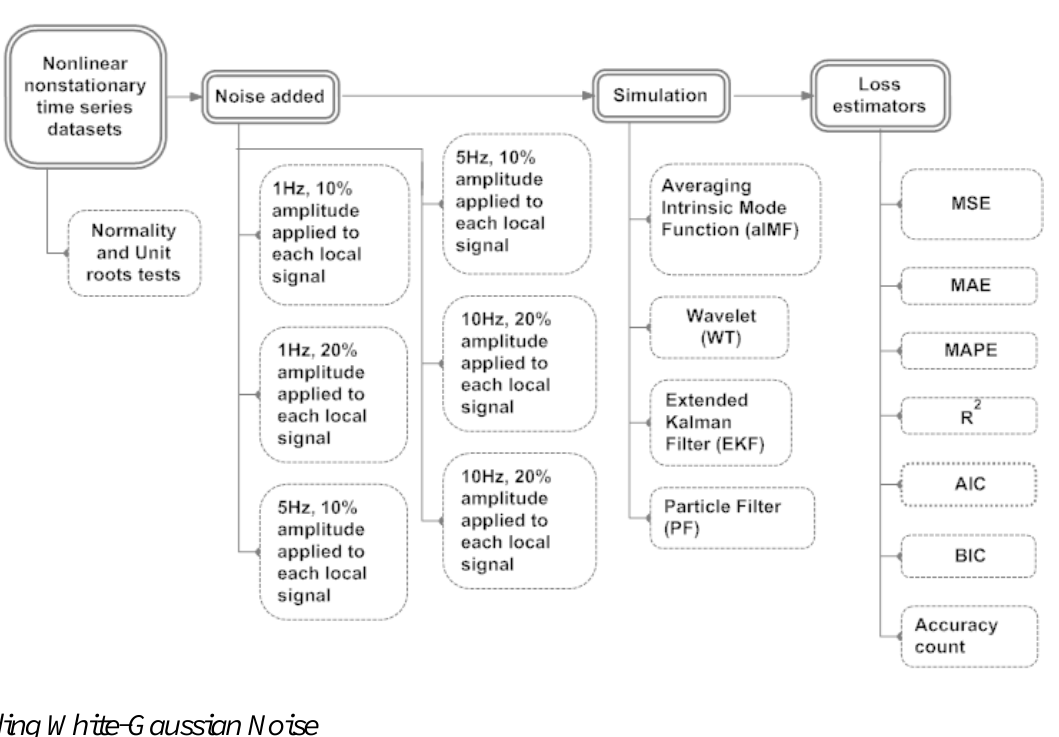
Figure 5. Flowchart shows simulation and results of aIMF, WT, EKF and PF.